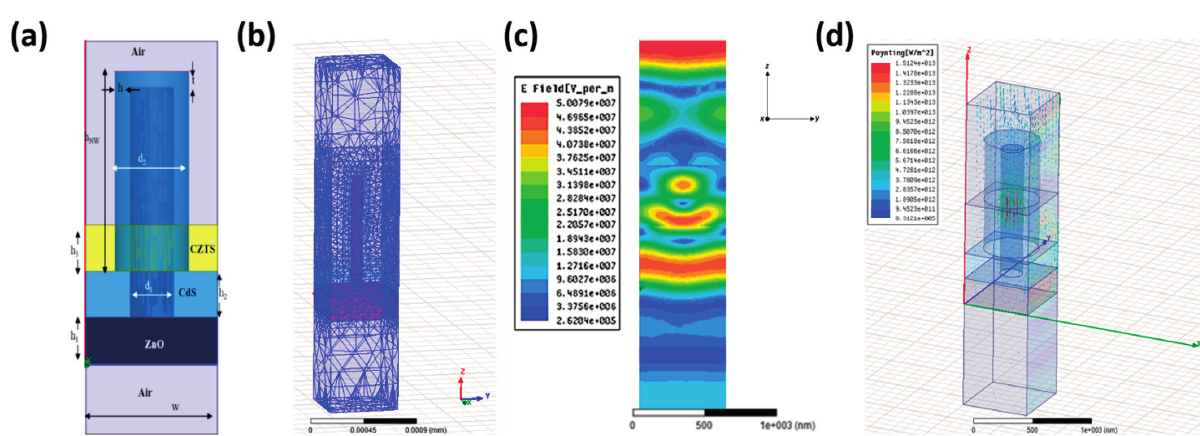
Figure 8. ( a ) Dimensions of a single unit cell. ( b )The meshed FE model. ( c ) The simulated electric field flux. ( d ) The simulated Poynting energy field in the unit